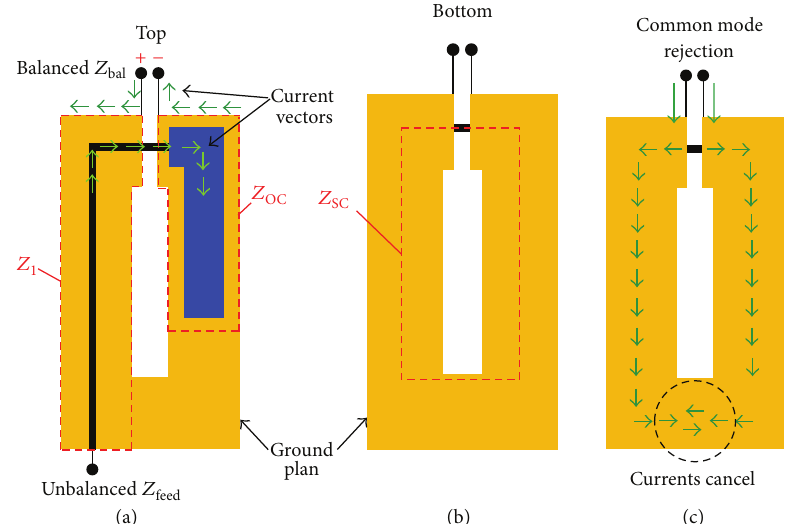
Figure 18: MTM array microstrip balun functionality depicting balanced currents and common mode rejection.